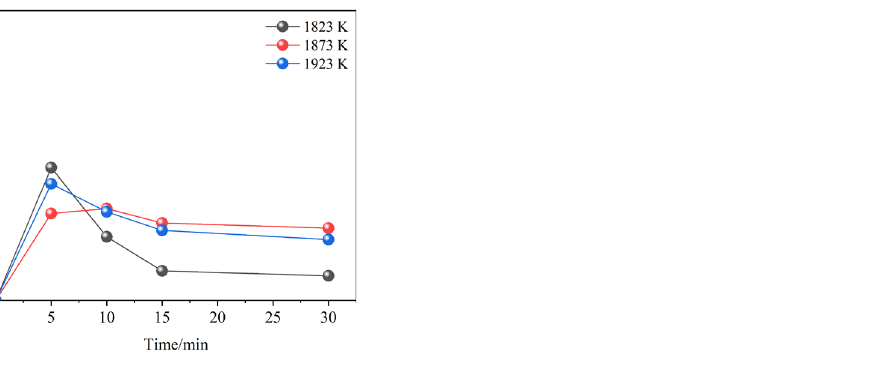
Figure 3. Effect of smelting temperature on Sb removal ratio at slag = 5 wt%, initial Sb = 0.06 wt%, initial C content = 0.05 wt%, and initial CaC 2 = 20 wt%.